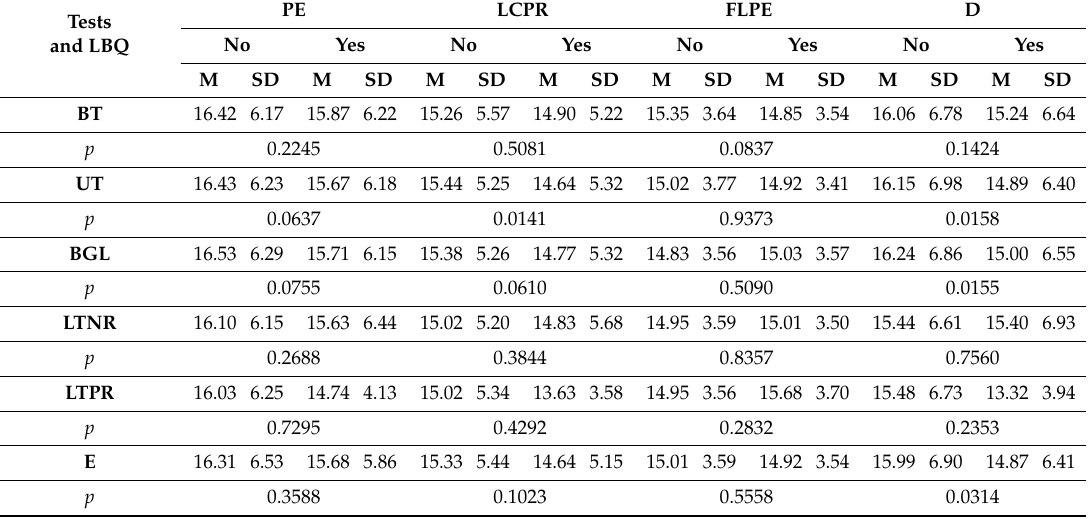
Table 7. Nurses self-assessed preparedness for writing referrals for diagnostic tests and their level of occupational burnout (as assessed by